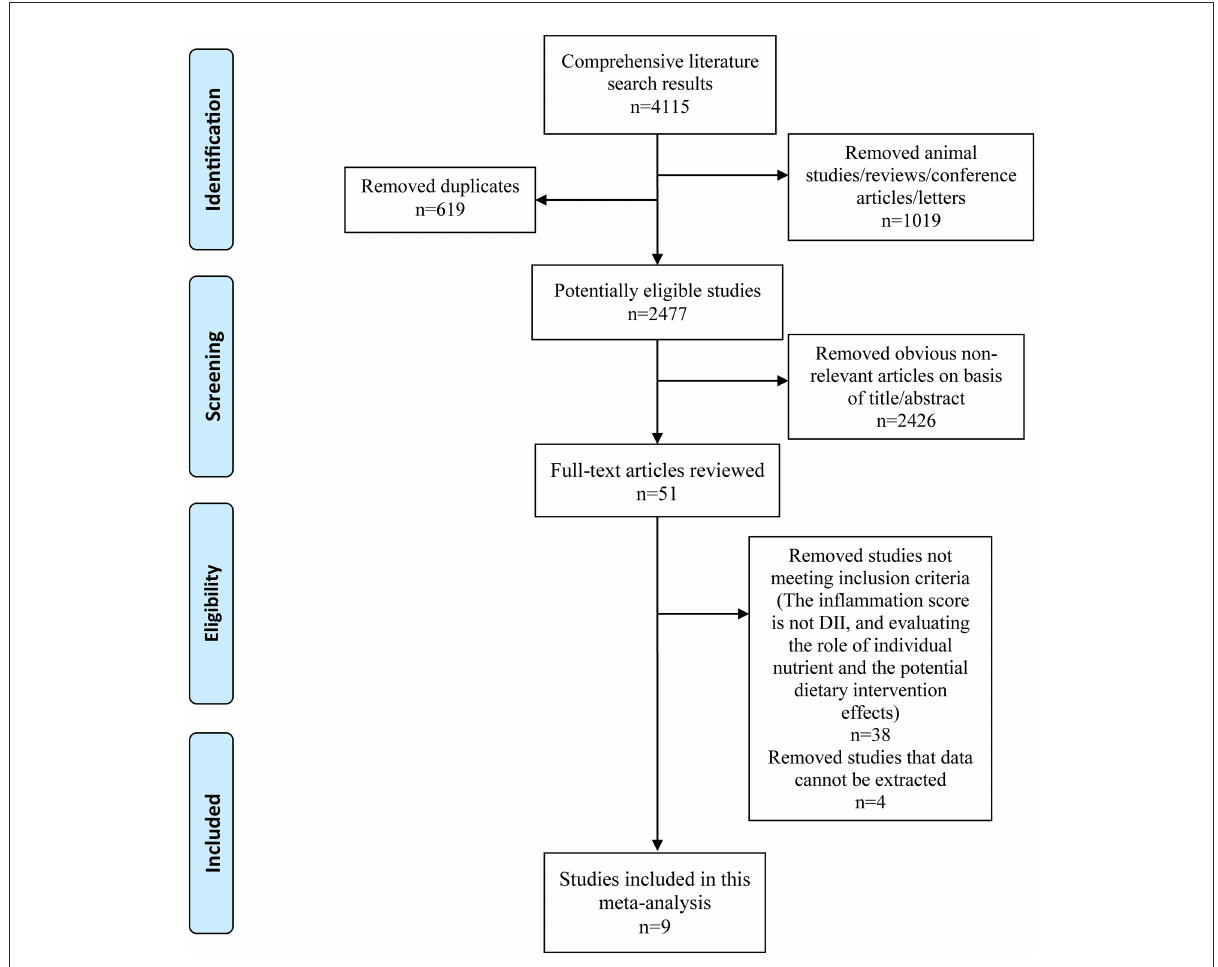
FIGURE1 Flow diagram of the literature search and